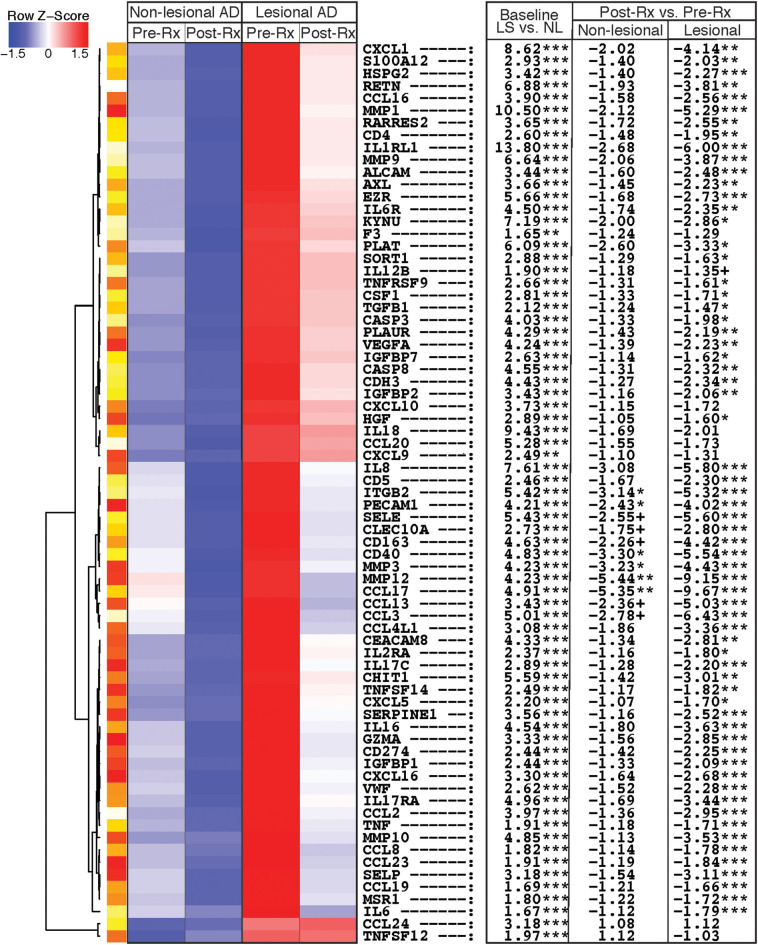
Heatmap of immune and atherosclerosis/cardiovascular proteins. Heatmap of immune and atherosclerosis and cardiovascular signaling proteins that are differentially expressed in tape-stripped skin of atopic dermatitis patients before and after dupilumab therapy, using the criteria of fold-change >1.5 and false discovery rate <0.05. Proteins are ordered by unsupervised hierarchical clustering, as represented by dendrogram on the left. The table on the right shows fold-changes in lesional vs. non-lesional tape-strips at baseline (LS vs. NL), and post- vs. pre-treatment with dupilumab (Post-Rx vs. Pre-Rx) for both non-lesional and lesional skin. LS, Lesional; NL, Non-lesional; Rx, Treatment.***FDR < 0.001, **FDR < 0.01, *FDR < 0.05, +FDR < 0.1.